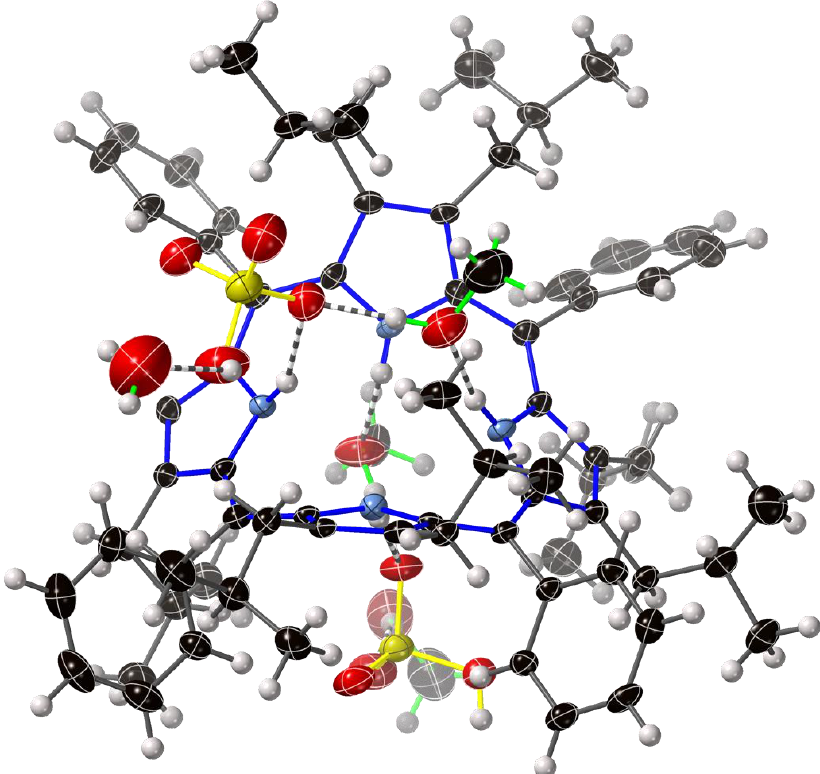
Figure 2. View of the molecular structure of H 4 OiBuTPP(HSO 4 ) 2 (H 2 O)(MeOH) 3 in the crystal (compound 1 ). The porphyrin core (blue bonds) is distorted such that the N – H moieties can form hydrogen bonds with solvates (green) and bisulfate anions (yellow). Ellipsoids are shown at 50% probability, minor components of structural disorder are omitted, and H atoms are shown as spheres of a fixed radius.